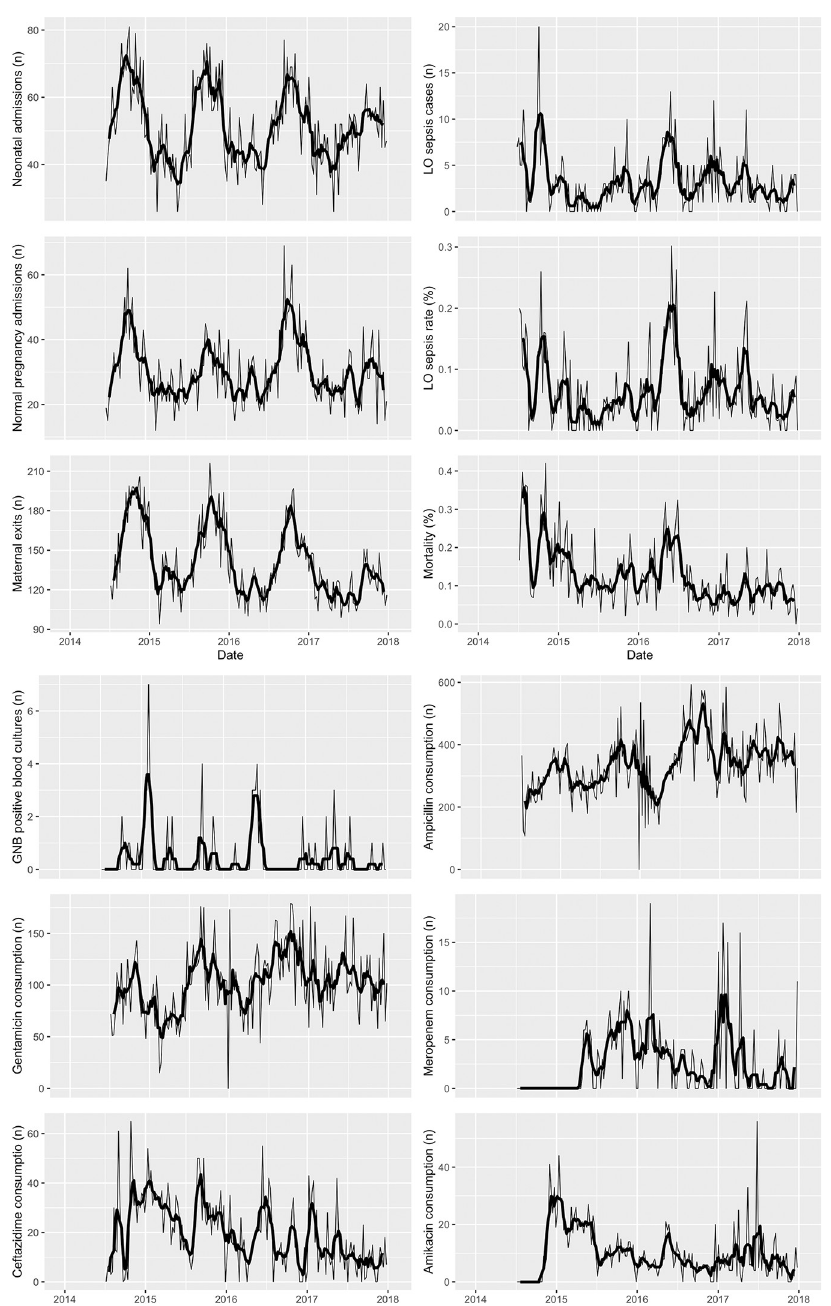
Fig 1. A and B: Weekly time series with five weekly moving average (thick black line) for routinely collected data on neonatal admissions, maternal exits, maternal admissions for normal pregnancies, neonatal mortality, LO sepsis cases, LO sepsis rates, GNB positive blood cultures and antibiotic consumption, July 2014 to December 2017, CRUO. specificity for weeks in which the GNB positive blood culture alarm was triggered was the LO sepsis rate aberration alarm (Table 4). In general, the specificity for all alarms was high ( > 84%) with weeks in which the GNB positive blood culture alarms were triggered. The sensi- tivity of all the alarms remained below 50% for the weeks in which the GNB positive blood